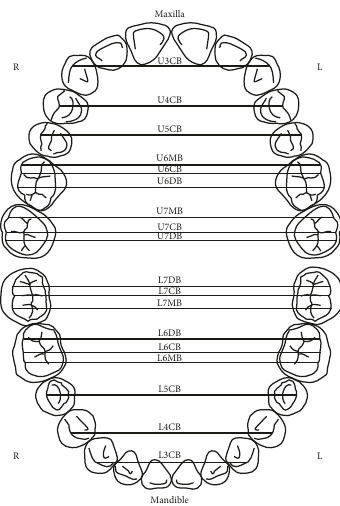
Figure 2: Illustration of the maxillary and mandibular arches’ widths as described by Ling and Wong [9]. U4CL: palatal cusp of tooth 14 and tooth 24; U5CL: palatal cusp of tooth 15 and tooth 25; U6ML: mesial palatal cusp of tooth 16 and tooth 26; U6DL: distal palatal cusp of tooth 16 and tooth 26; U7MB: mesial buccal cusp of tooth 17 and tooth 27; U7DB: distal buccal cusp of tooth 17 and tooth 27; L7DL: distal palatal cusp of tooth 37 and tooth 47; L7ML: mesial lingual cusp of tooth 37 and tooth 47; L6DL: distal lingual cusp of tooth 36 and tooth 46; L6ML: mesial lingual cusp of tooth 36 and tooth 46; L5CL: lingual cusp of tooth 35 and tooth 45; L4CL: lingual cusp of tooth 34 and tooth